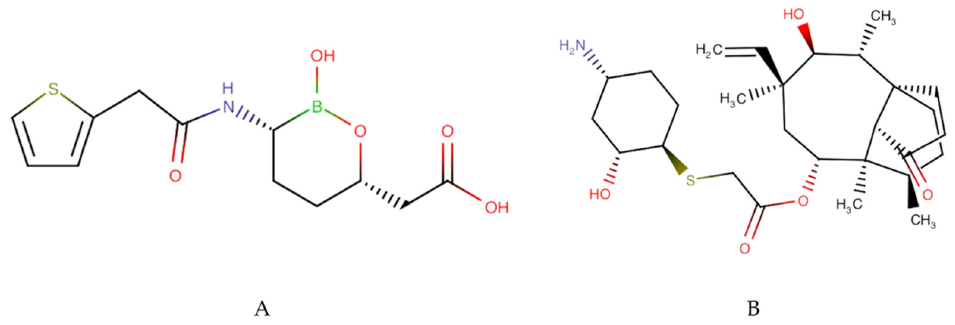
Figure 1. Chemical structures of ( A ) vaborbactam and ( B ) lefamulin. Vaborbactam, a beta-lactamase inhibitor, has been used clinically for the treatment of complicated urinary tract infections (cUTI) in combination with meropenem. Vaborbactam has good inhibitory activity against serine beta-lactamases, including Klebsiella pneumoniae carbapenemase (KPC). Currently, therapy using meropenem-vaborbactam is only given parenterally at a 1:1 ratio. Reported clinical data so far indicate this drug